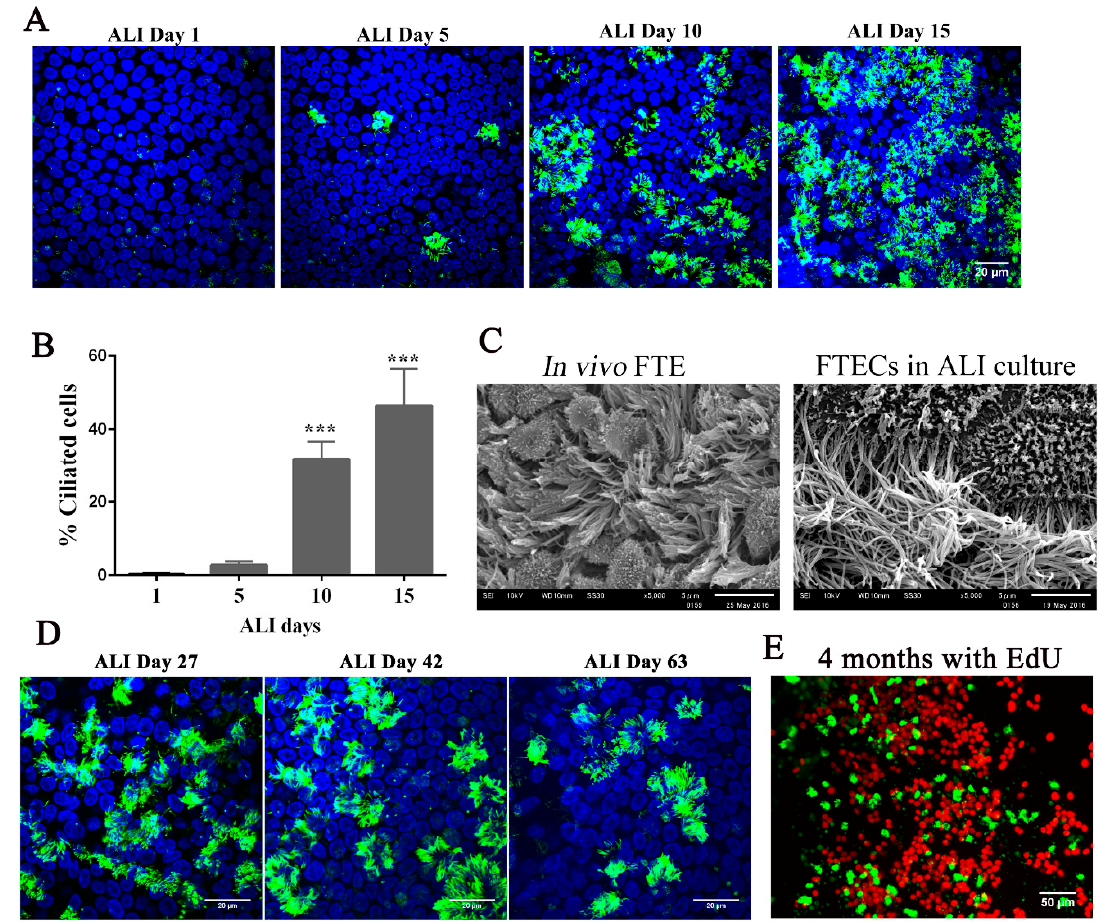
Figure 4. Inducing the differentiation of fallopian tube epithelium cells (FTECs) in air–liquid interface (ALI) culture. ( A ) Differentiation of FTECs was induced by adding 2 ng/mL estradiol (E2). Cells were stained with an anti-Ac-tubulin antibody (cilia, green) and DAPI (nuclei, blue) at ALI culture days 1, 5, 10, and 15. Scale bars: 20 µm. ( B ) Quantification of Ac-tubulin-positive cells (ANOVA test, n = 5, compared with ALI culture day 1 group). ( C ) Gross appearance of FTE tissue in vivo and differentiated FTECs cultured in ALI. ( D ) FTECs were thawed and cultured with 2 ng/mL E2 in basal medium. Cells on ALI culture days 27, 42, and 63 were stained with anti-Ac-tubulin antibody (green) and DAPI (blue). Scale bars: 20 µm. ( E ) FTECs were cultured with 2 ng/mL E2 in basal medium for 4 months. 10 µM Edu was added to the medium (bottom chamber) for 1 week, then cells were fixed and stained with anti-Ac-tubulin antibody (green) and DAPI (blue), and Edu-positive cells are shown in red. Scale bars: 50 µm. *** p < 0.001.